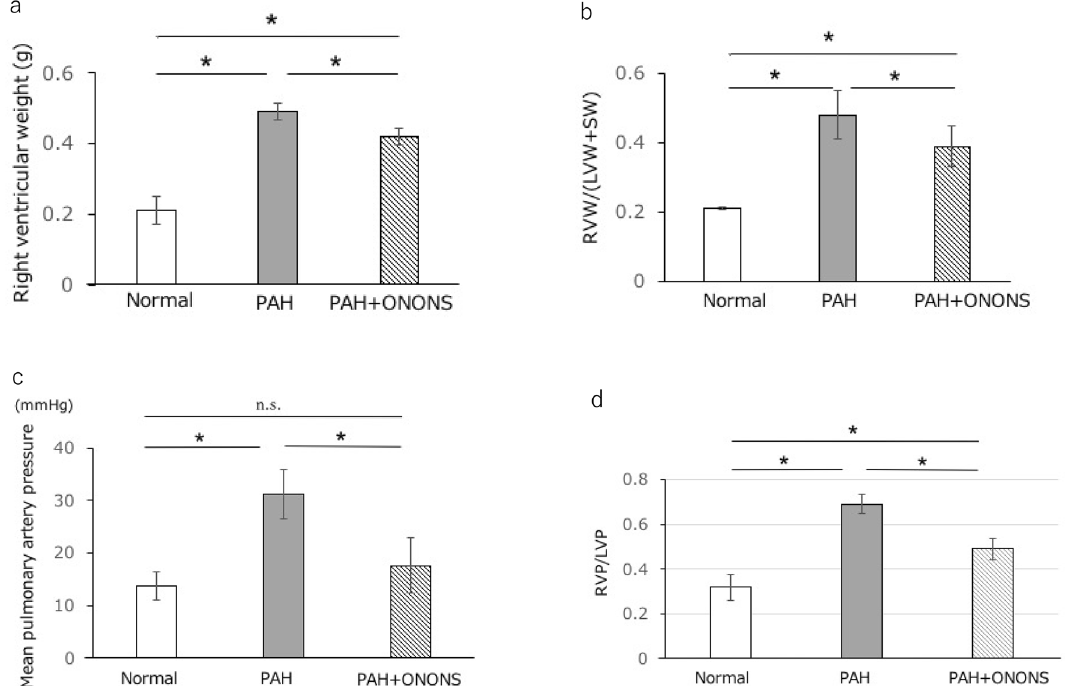
Figure 8. Hemodynamic effects of ONO1301 nanospehre (ONONS) in pulmonary artery hypertension (PAH) rats. ( a ) Right ventricle weight. ( b ) The weight ratio of the right ventricle to the left ventricle and septum (RVW/ LVW + SW). ( c ) Mean pulmonary artery pressure. ( d ) The pressure ratio of right ventricle to left ventricle. These date showed that ONONS attenuated pulmonary hypertension in PAH rats. * P < 0.05. n =